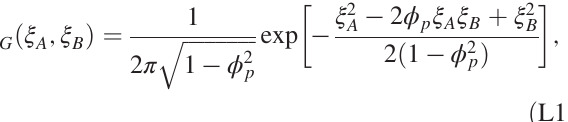
ffiffiffiffiffiffiffiffiffiffiffiffiffiffi p 1 þ ϕ